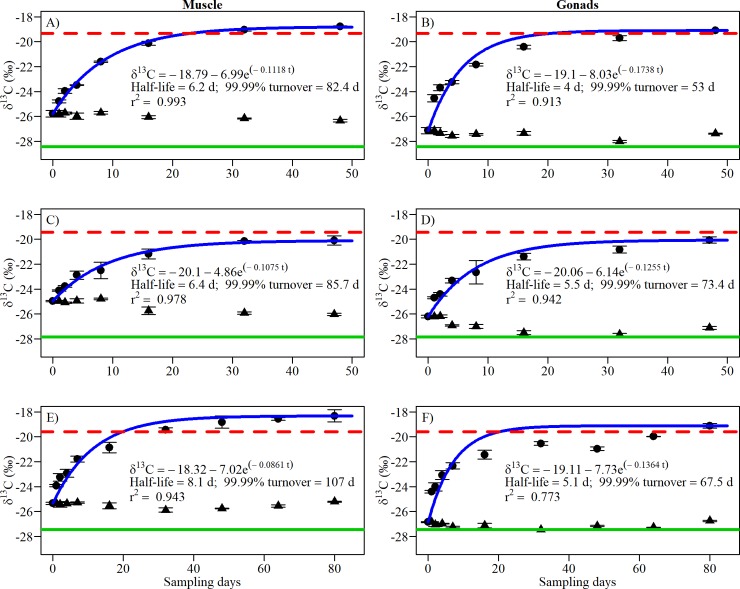
δ13C values of muscle (left) and gonad tissue (right) per sampling day (mean ± SE) for three species of freshwater snails fed low-protein (triangles) or high-protein diet (dots).(A–B) Helisoma trivolvis, (C–D) Lymnaea elodes and (E–F) Lymnaea stagnalis. For each graph, the blue curve is the best fit, the dotted red line represents the mean δ13C value of the high-protein diet (n = 2 for A–F), and the green line represents the mean δ13C value of the lettuce diet (n = 4 for A–B, 5 for C–D, 3 for E–F).